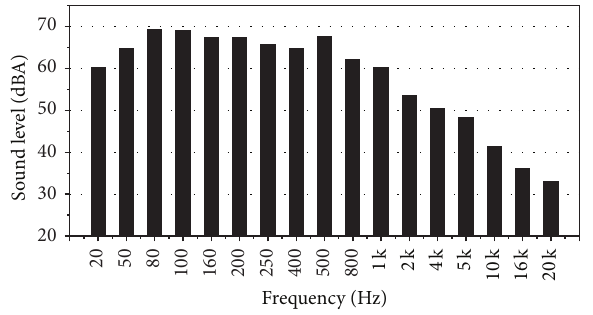
Figure 1: Transformer noise